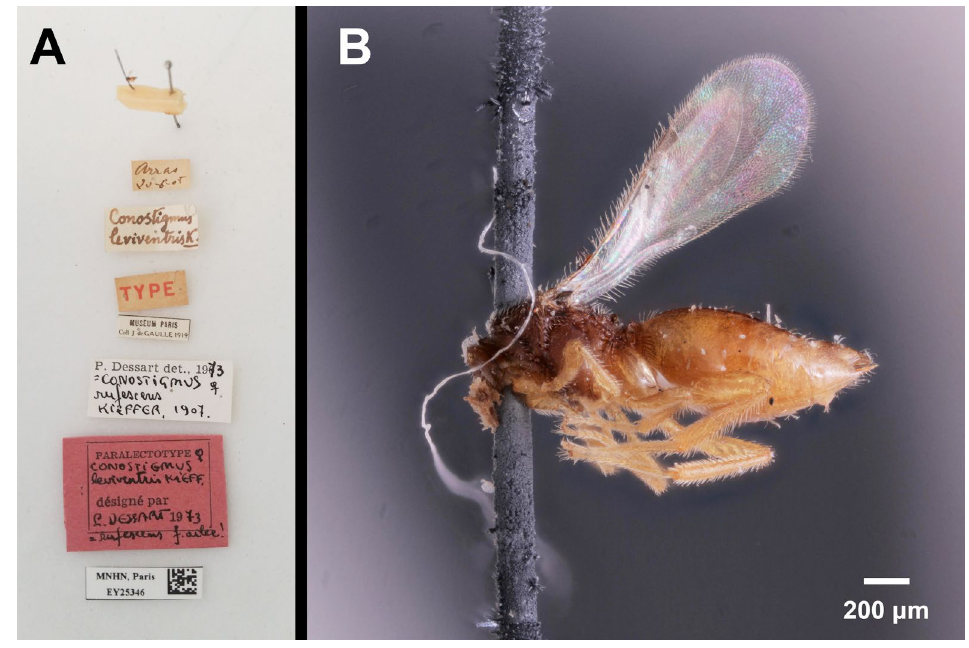
Fig. 20. Conostigmus leviventris kieffer, 1907. A . Labels. B . Paralectotype, ♀, lateral habitus (MNHN